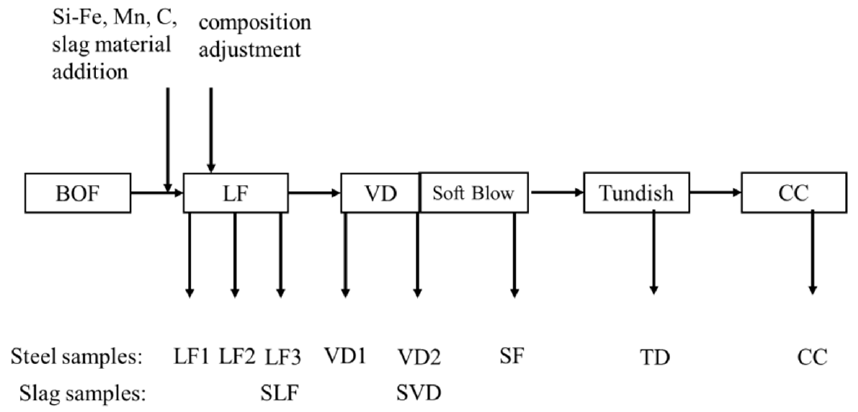
Figure 1. Process of industrial trials and sampling locations.